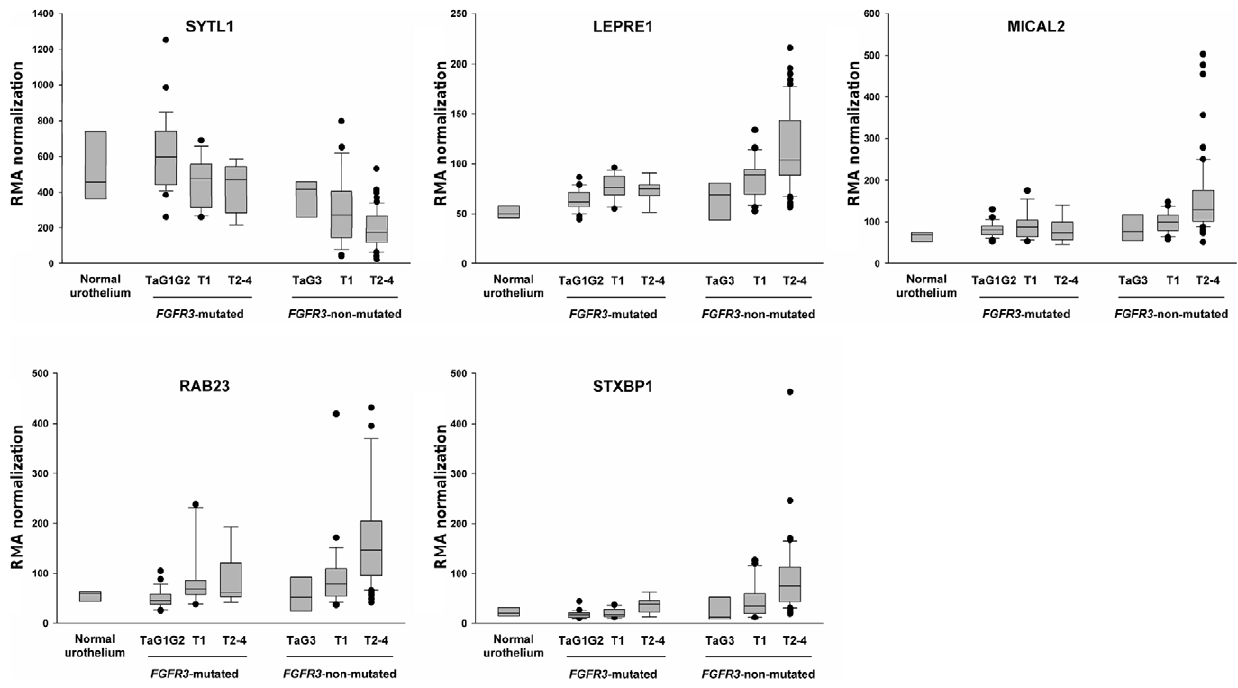
Figure 7. Expression in normal samples and in the two groups of tumors (mutated and non-mutated for FGFR3 ) classified according to stage, of the genes found to be specifically deregulated in one of the two pathways of bladder tumor pathogenesis. Expression of SYTL1 , LEPRE1 , MICAL2 , RAB23 and STXBP1 measured by Affymetrix array in normal samples (n=4) and FGFR3 -mutated tumor samples (TaG1G2, n=28; T1, n=13; T2-4, n=9), and FGFR3- non-mutated samples (TaG3, n=3; T1, n=25; and T2-4, n=63). Are represented the 10th percentile (below bar), the 25th percentile (box bottom), the median (bar in the box), the 75 th percentile (box top) and the 90 th percentile (upper bar). The points represent the outlier samples. SYTL1 is down-regulated in FGFR3 -non-mutated tumors, whereas LEPRE1 , MICAL2 , RAB23 and STXBP1 are up-regulated.